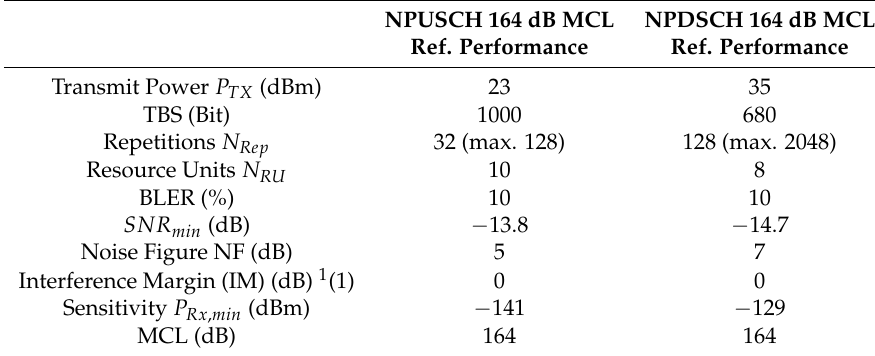
Table 2. Reference link budget configuration achieving the minimum requirement of MCL = 164 dB for 5G mMTC systems as defined by IMT-2020 [19] with 32 and 128 repetitions in uplink and downlink (adapted from